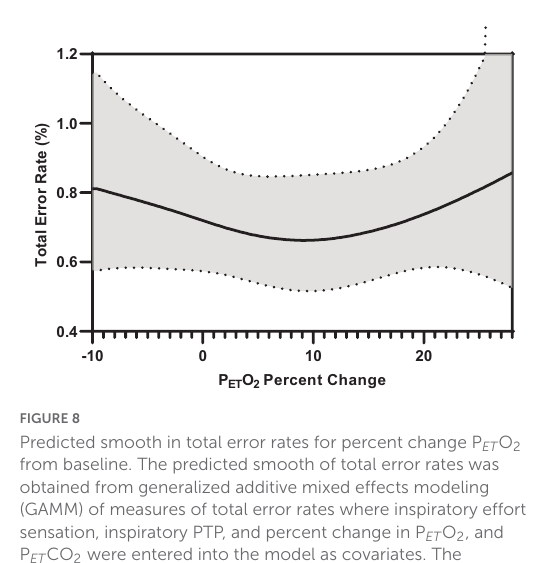
FIGURE7 Predicted smooth in total error rates across inspiratory effort sensation. The predicted smooth of total error rates was obtained from generalized additive mixed effects modeling (GAMM) of measures of total error rates where inspiratory effort sensation, inspiratory PTP, and percent change in P ET O 2 , and P ET CO 2 were entered into the model as covariates. The predicted smooth curve was produced for total error rates by setting all other covariates at their means (inspiratory PTP = –32.65 cmH 2 O · s; (cid:49) P ET O 2 = 7.31%; (cid:49) P ET CO 2 = –4.04%). The dashed curves show the 95% CIs around the prediction.